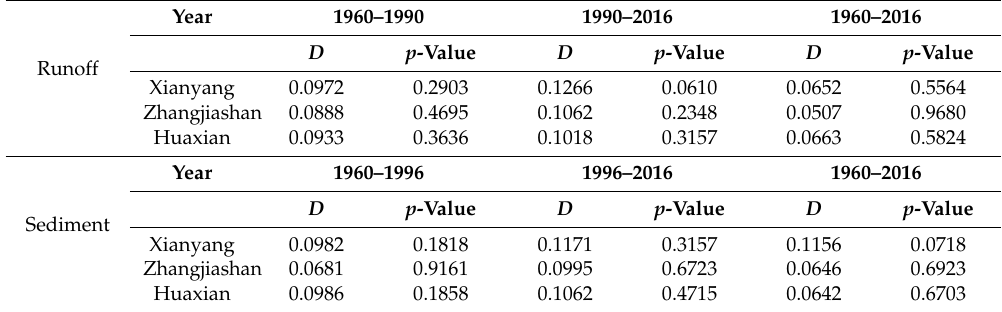
Table 1. Function fitting results of marginal distribution.